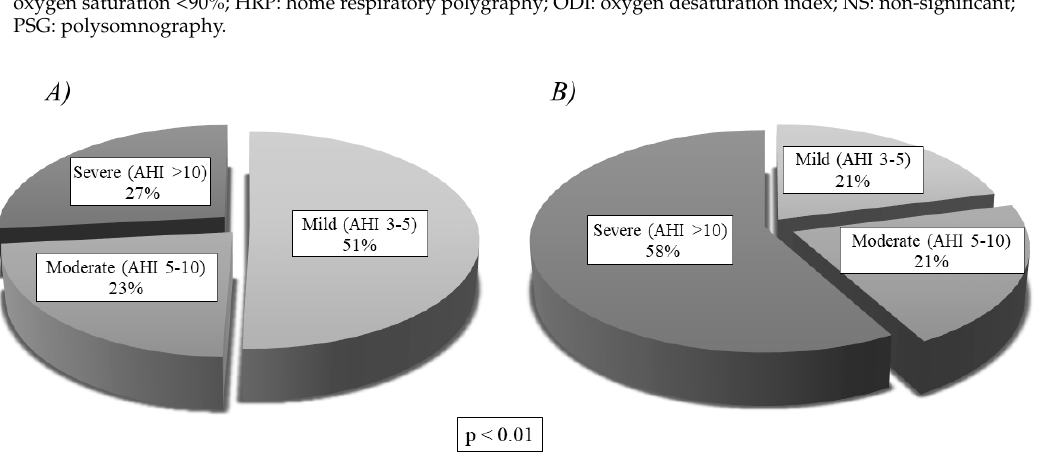
Figure 5. OSAS severity levels by group, showing statistically significant differences ( p < 0.01): ( A ) Severity of Group A (Home Respiratory Polygraphy); ( B ) Severity of Group B (Polysomnography). AHI: apnea-hypopnea index.